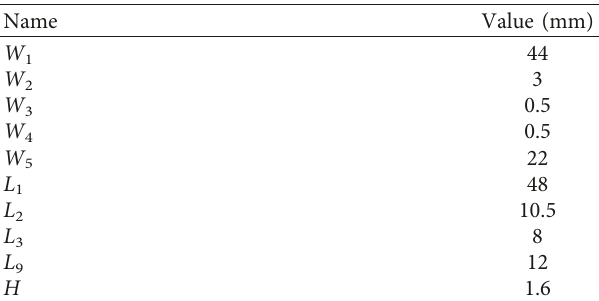
Figure 4: WLAN/WiMAX multiband MSA. (a) Structure of WLAN/WiMAX multiband antenna. (b) WLAN/WiMAX multiband antenna model in HFSS. Table 2: Fixed parameters of the WLAN/WiMAX multiband